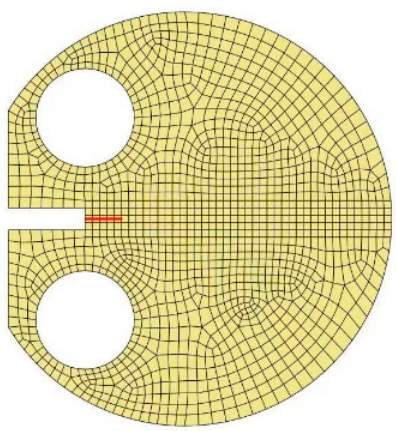
Figure 6. Meshing of the RCT specimen used in XFEM.